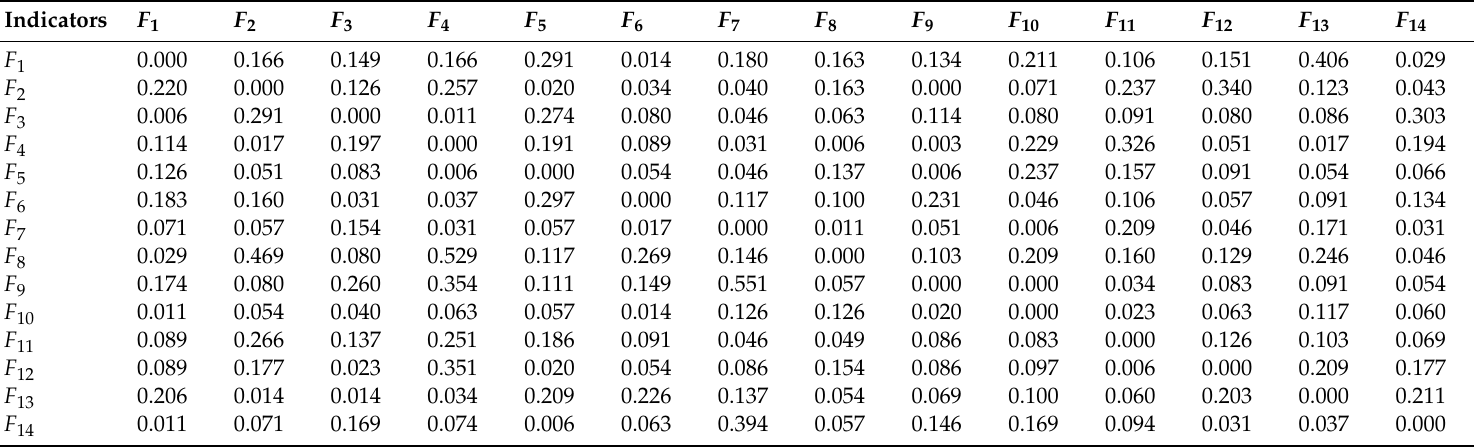
Table 3. Distance matrix of the first